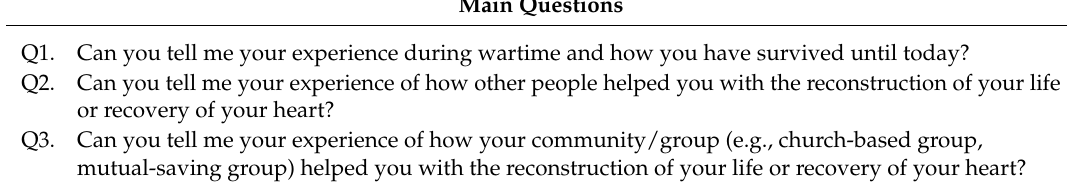
Table 2. Interview topic guides. Main